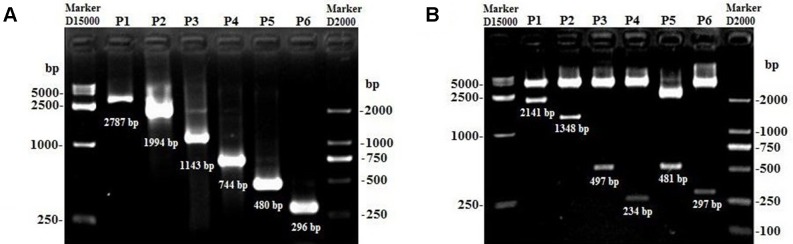
The products of lncFAM200B promoter fragments and the identification of the plasmids using different restriction enzymes. (A) P1 to P6 represented the PCR products of pGL3-pro1 to pGL3-pro6. (B) P1 to P6 represented the recombined plasmids of pGL3-pro1 to pGL3-pro6 digested by different restriction enzymes.